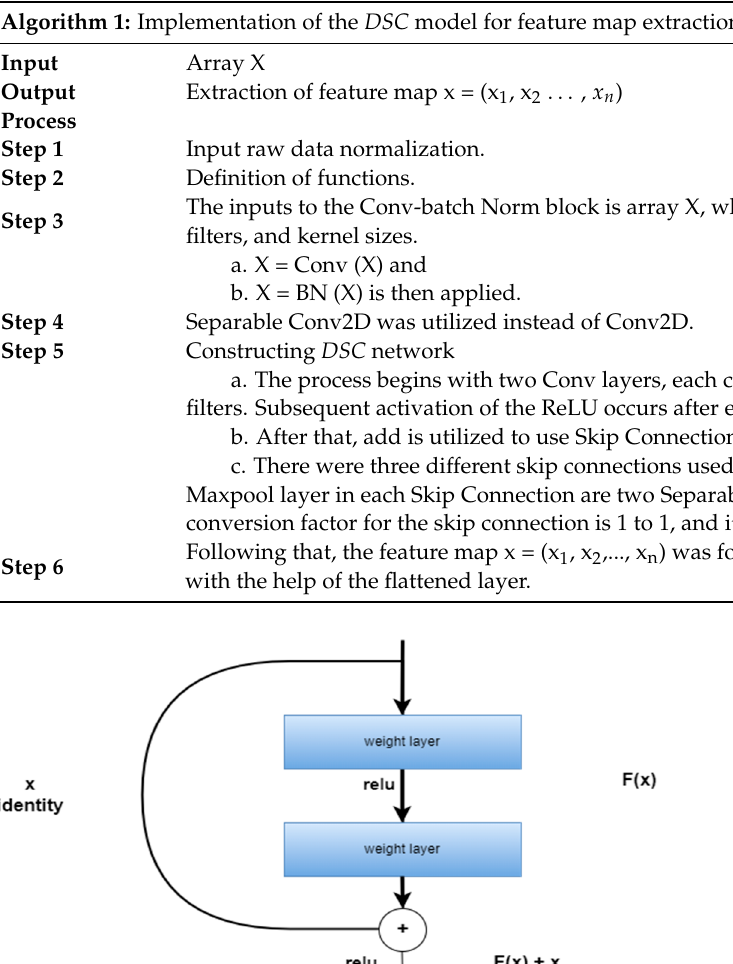
Algorithm 1: Implementation of the DSC model for feature map extraction